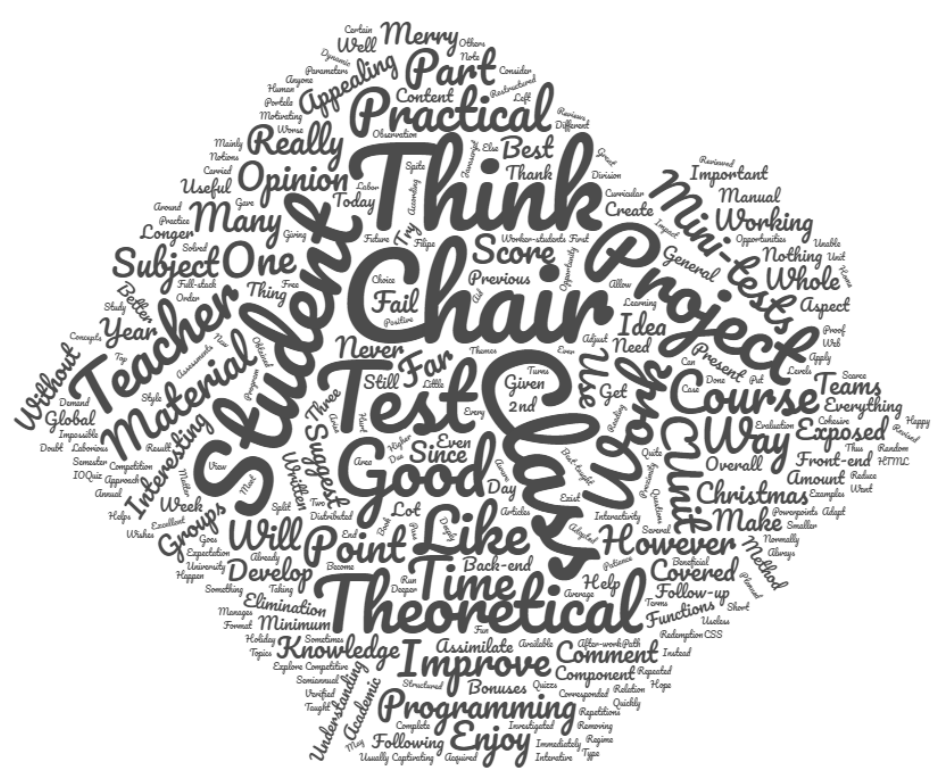
Figure 7. Students’ suggestions/opinions.